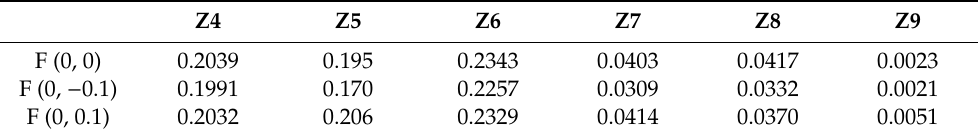
Table 6. Root mean square error (RMSE) of the Zernike coe ffi cient under multiple fields of view.